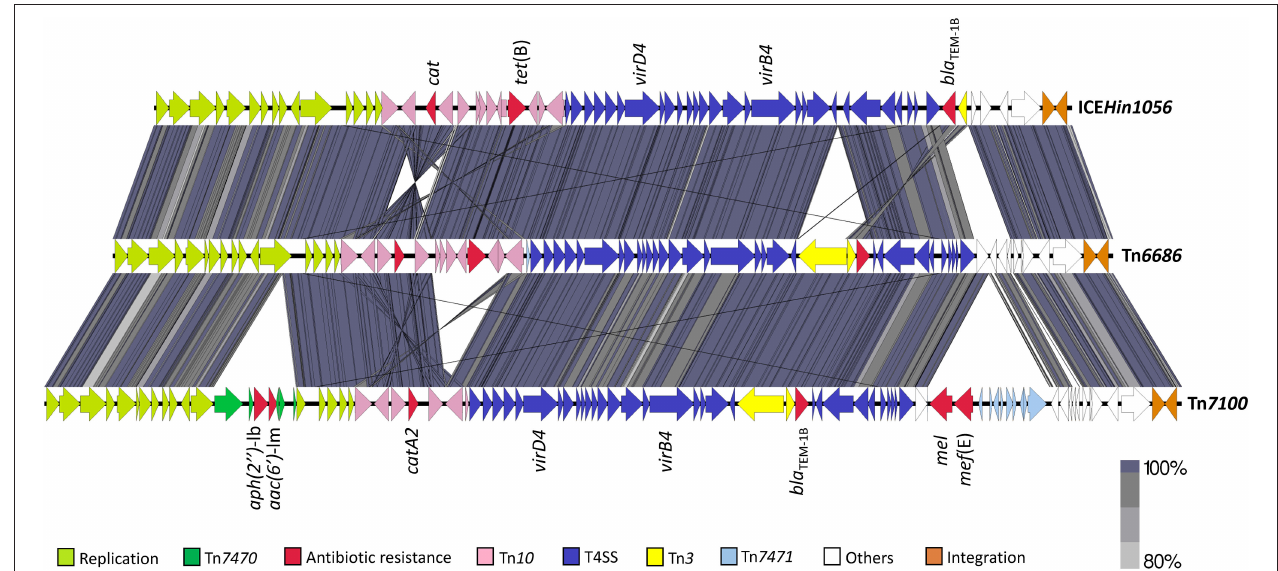
FIGURE 1 | Pairwise comparison of Tn 7100 with Tn 6686 (MN106411) and comparison of Tn 6686 with ICE Hin1056 (AJ627386). The gray/purple bands represent the forward and reverse matches. Transposable elements, functional regions, and antibiotic resistance determinants are indicated by colored arrows. T4SS, type IV secretion system.